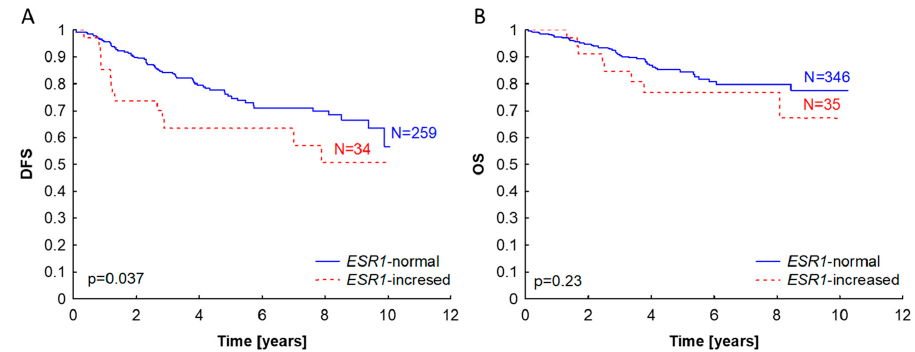
Figure 1. Kaplan–Meier survival curves according to ESR1 gene dosage status (measured by qPCR) in primary breast tumors. ESR1 -normal status was described as ESR1/APP ratio <2, ESR1 -increased as ESR1/APP ratio ≥ 2. The probability of disease-free survival ( A ) and overall survival ( B ) are shown.